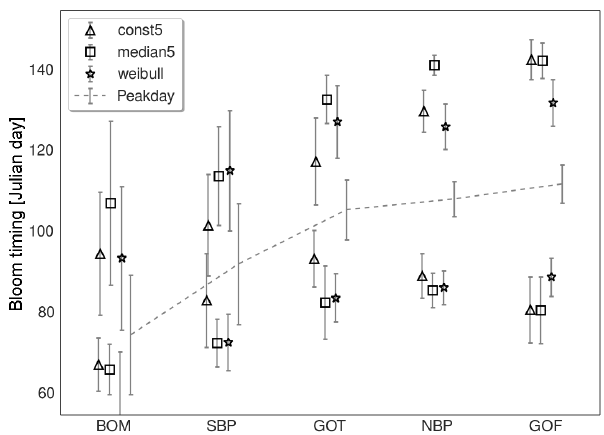
Figure 4. Bloom timing (bloom start, peak, and end day) for each sea area along the routes in Fig. 2, averaged over the period 2000 to 2014, and for all applied bloom metrics. Whiskers indicate standard deviations over the 15-year study period. The bloom peak day is independent of the chosen metric and plotted separately. The sea areas are ordered by latitude, from south to